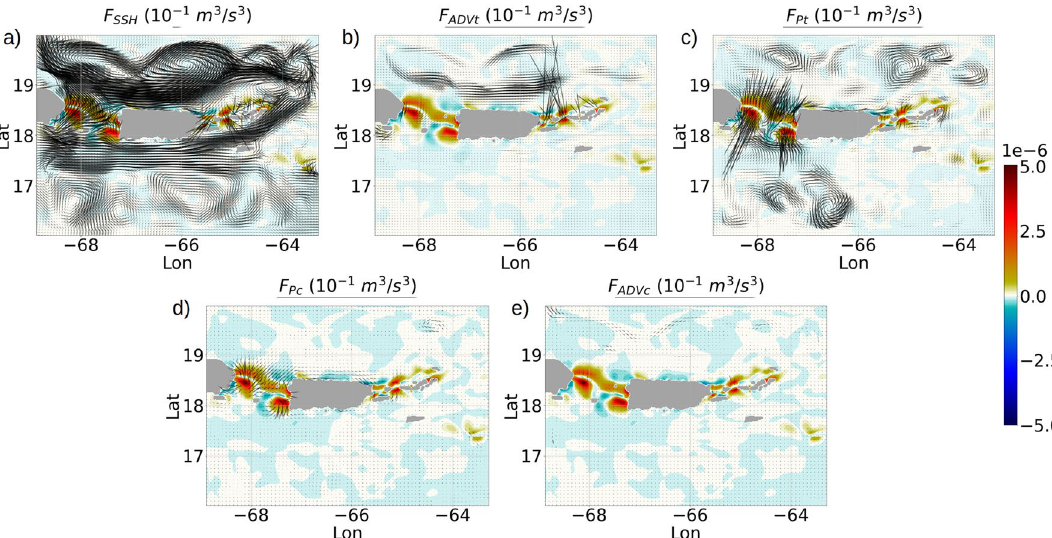
Figure 8. Quiver plots showing the depth-averaged energy fluxes for E BTK (refer to Eq. B11): ( a ) F SSH , ( b ) F ADVt , ( c ) and F Pt , and the depth-averaged energy fluxes for E BCK : ( d ) F Pc , ( e ) F ADVc . The color contours show the depth-averaged conversion term C . The arrow lengths denote the flux magnitudes. We preferred to keep the arrow scales different for each plot in order to show the fields prominently. All data are averaged over 1 month to minimize the meso and submesoscale